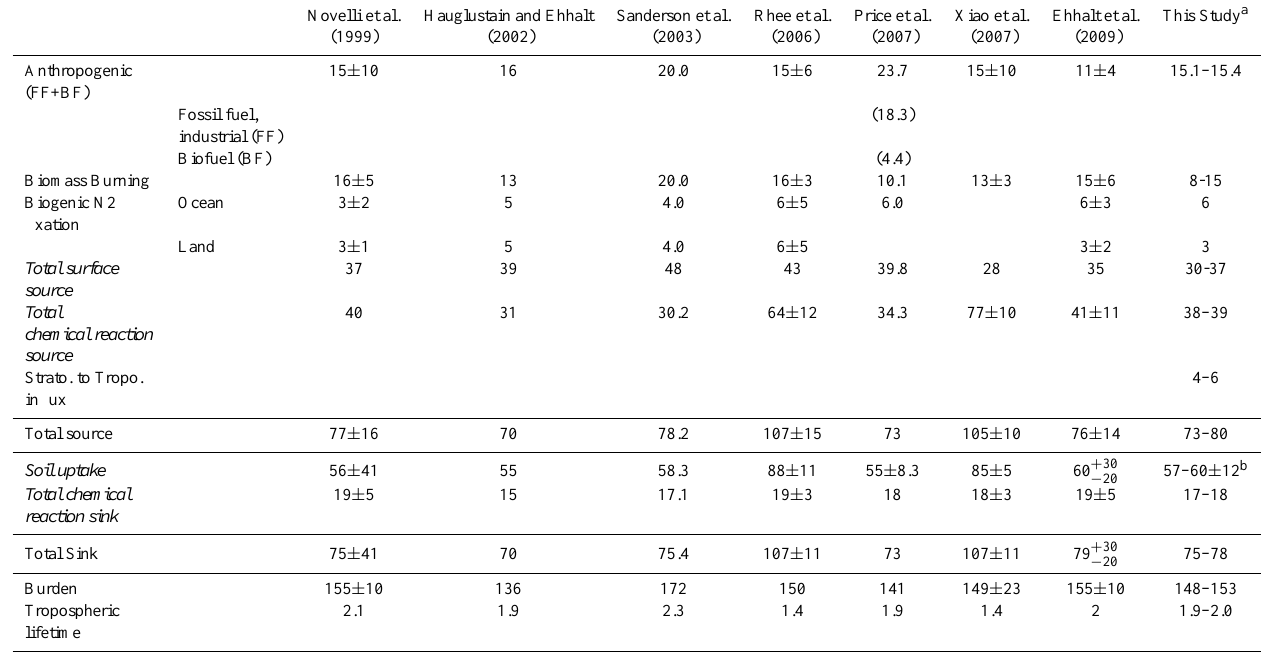
Table 2. Global tropospheric sources and sinks of H 2 (TgH 2 yr − 1